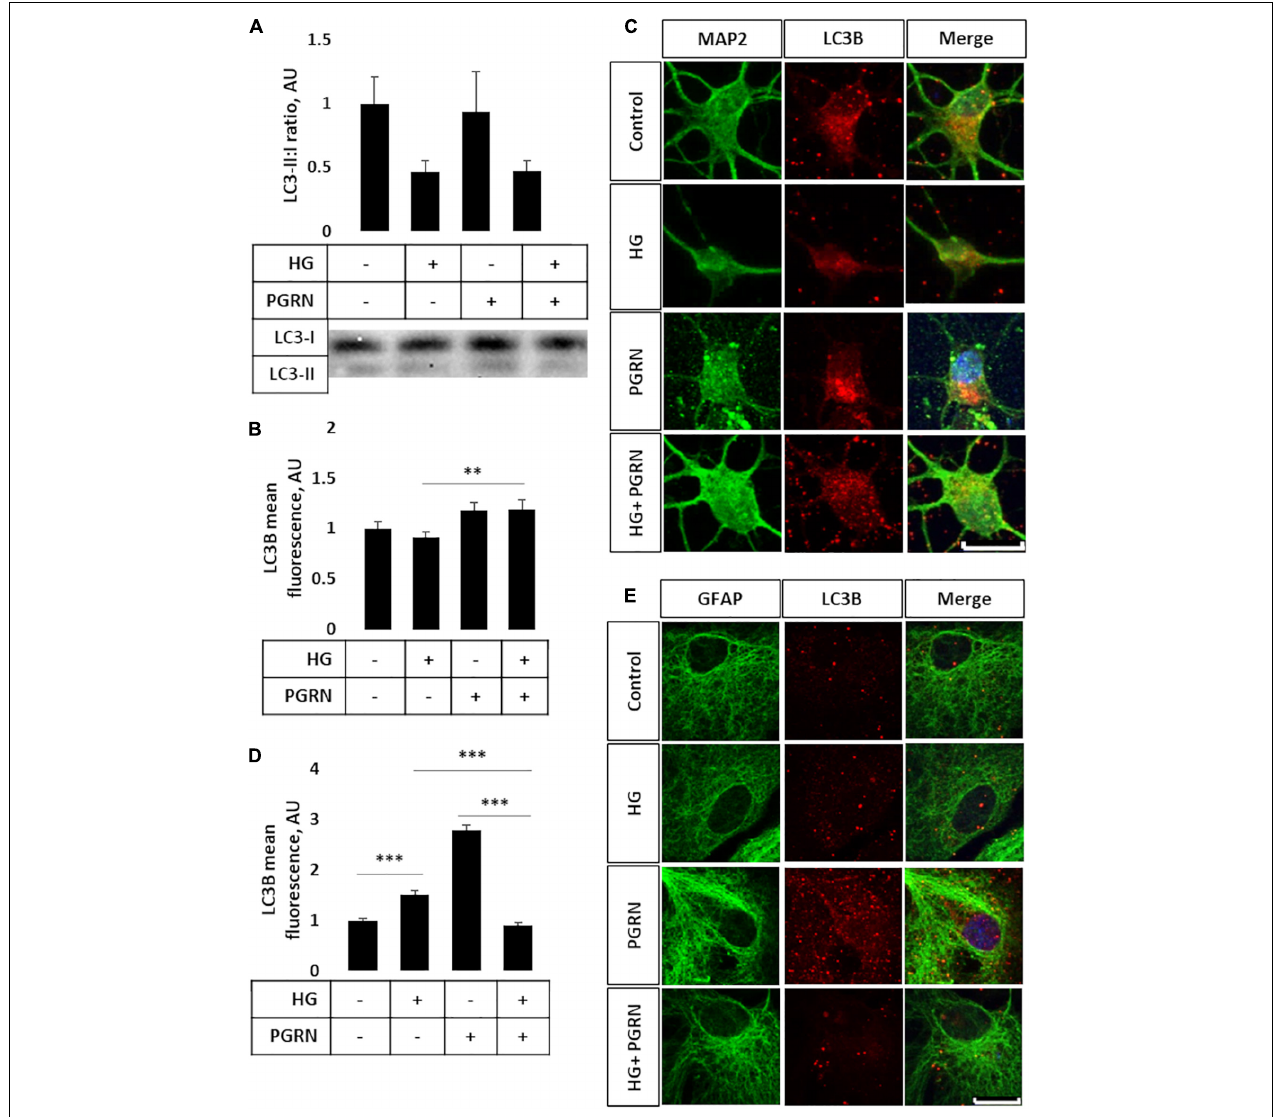
FIGURE 3 | LC3B lipidation and punctate formation in cortical neurons due to high glucose and PGRN. (A) Western blot analysis of LC3 lipidation (i.e., LC3-II:I ratio) in primary cortical neurons after 72 h of treatment. The LC3-II:I ratio decreased from control to high glucose (1.000 ± 0.208 AU to 0.464 ± 0.092 AU), an effect that appeared unaffected when treated with PGRN alongside high glucose (0.474 ± 0.076 AU). No difference was observed between control and PGRN-treated samples (0.938 ± 0.309 AU). N = 9 samples. (B) Immunofluorescence analysis of LC3B puncta expression in neurons after 72 h of treatment. The amount of punctate expression trended toward an increase due to PGRN (from 1.000 ± 0.069 AU, to 1.183 ± 0.077 AU). This difference was significant under high-glucose conditions (from 0.916 ± 0.045 AU, to 1.190 ± 0.097 AU). N = 11-29 cells. (C) Representative immunofluorescence images of primary neurons after 72 h of treatment, with blue as DAPI, green as MAP2, and red as LC3B. Scale bar, 10 µ m. (D) Immunofluorescence of LC3B puncta expression in astrocytes after 72 h of treatment increased significantly due to high glucose as well as PGRN treatment (from 1.000 ± 0.0374 AU to 1.512 ± 0.087 AU and 2.792 ± 0.099 AU, respectively). This decreased to control levels under HG + PGRN treatment, to 0.899 ± 0.049 AU. N = 12-29 cells. (E) Representative immunofluorescence images of primary astrocytes after 72 h of treatment, with blue as DAPI, green as GFAP, and red as LC3B. Scale bar, 10 µ m. ∗∗ p < 0.01; ∗∗∗ p <